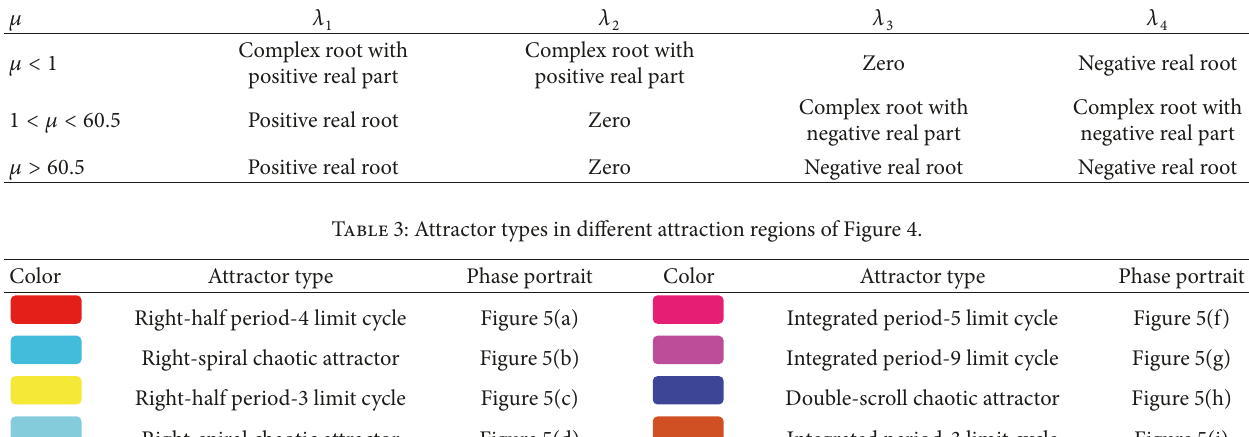
Table 2: Eigenvalues of line equilibrium point 𝑆 ± in different initial condition regions of 𝜇 .